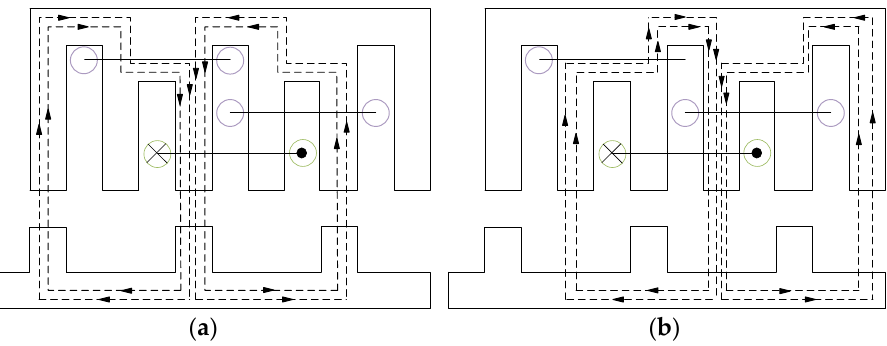
Figure 5. ( a ) Maximum forward position of flux linkage. ( b ) Maximum reverse position of flux linkage.